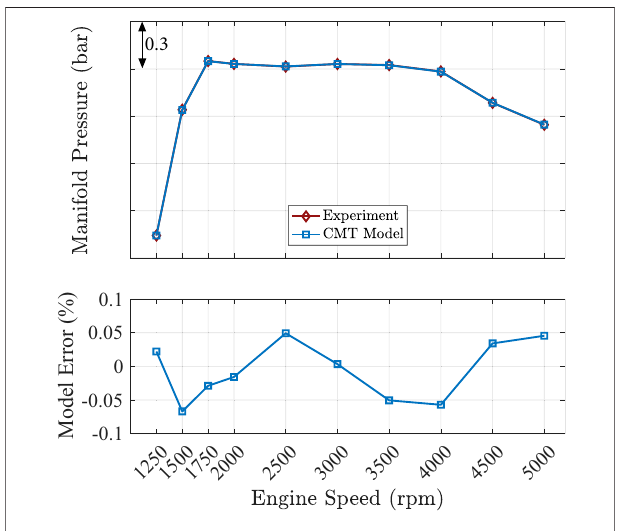
FIGURE 10 | SCV opened inlet manifold boost pressure from the PID controller.